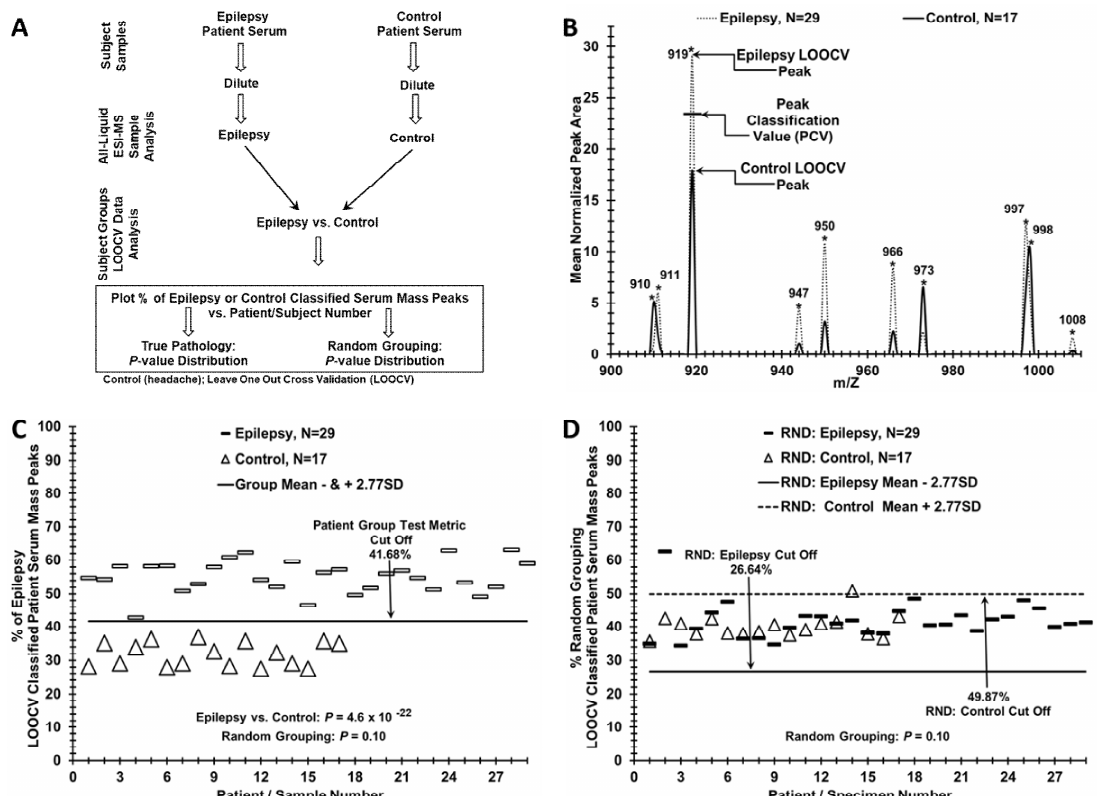
Figure 1. Distinguishing Epilepsy vs. Control patients using leave one [serum sample] out cross-validation/ peak classification value (LOOCV/PCV) serum mass peak analysis. ( A ) Flow chart outlining the serum sample handling and mass spectrometry processing of the binary patient/subject group analysis. ( B ) Serum mass peak Scoring of the LOOCV/PCV (leave (one serum sample) out cross-validation/peak classification value) procedure used to classify mass peaks either as “epilepsy” or as “control” for a “left out” sample, (a limited sample range 900–1008 m/z is displayed) of significant group discriminatory mass peaks. The PCV example for the peak at 919 is exhibited and used to classify “left out” peaks as either “epilepsy” (peak area above this PCV) or control (peak area at or below this PCV). ( C ) Serum discrimination of epilepsy patients (dashes) from controls (triangles) by a % of LOOCV classified mass peaks. A cut off value is indicated (− or + SDs from the seizure or control groups respectively) to determine test metric values (e.g., true positives). ( D ) A lack of serum sample discrimination is demonstrated which results when the two different sample groups are mixed together randomly followed by the same LOOCV mass peak analysis.